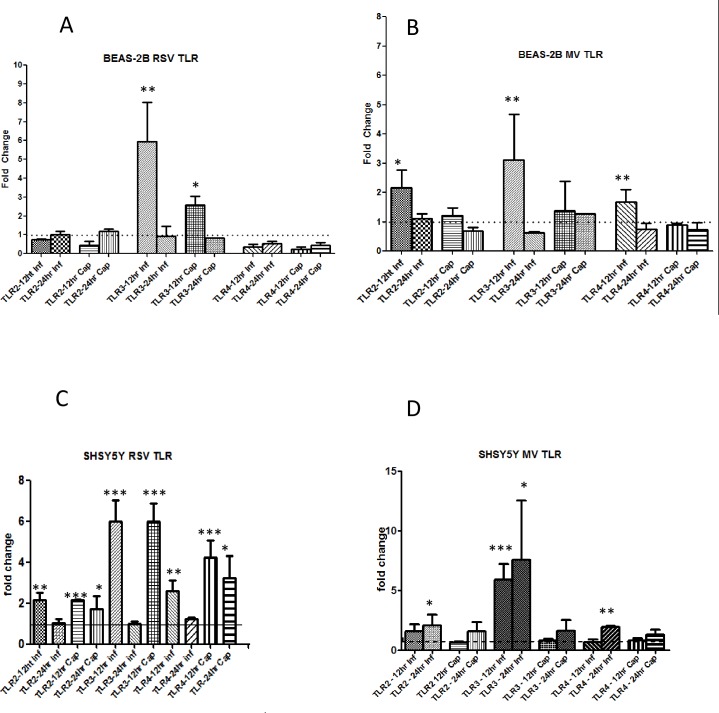
RSV and MV infection induce cell surface TLRs in BEAS-2B and SHSY5Y cells.BEAS-2B and SHSY5Y cells were infected with RSV (MOI 0.1) and MV (MOI 1) or treated with capsaicin (10 μM) for 12 and 24 hours. TLR2, TLR3 and TLR4 levels were determined by qRT-PCR. Data is presented as relative fold change to TLR mRNA levels in uninfected/untreated control cultures. (A) and (B) BEAS-2B cells, (C) and (D) SHSY5Y cells. (A) and (C) RSV, (B) and (D) MV.